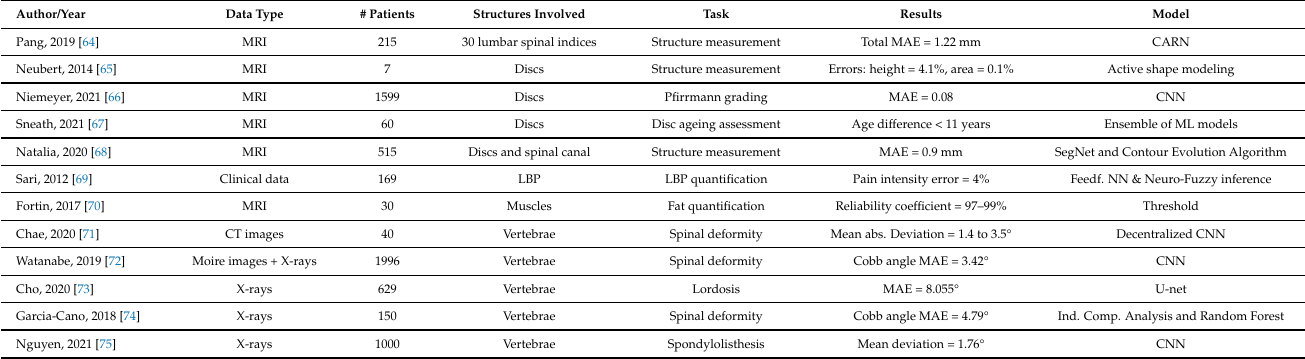
Abbreviations: Cascade Amplifier Regression Network (CARN), Magnetic Resonance Imaging (MRI), Computed Tomography (CT), Low Back Pain (LBP), Mean Absolute Error (MAE), Neural Network (NN), Machine Learning (ML), Convolutional Neural Network